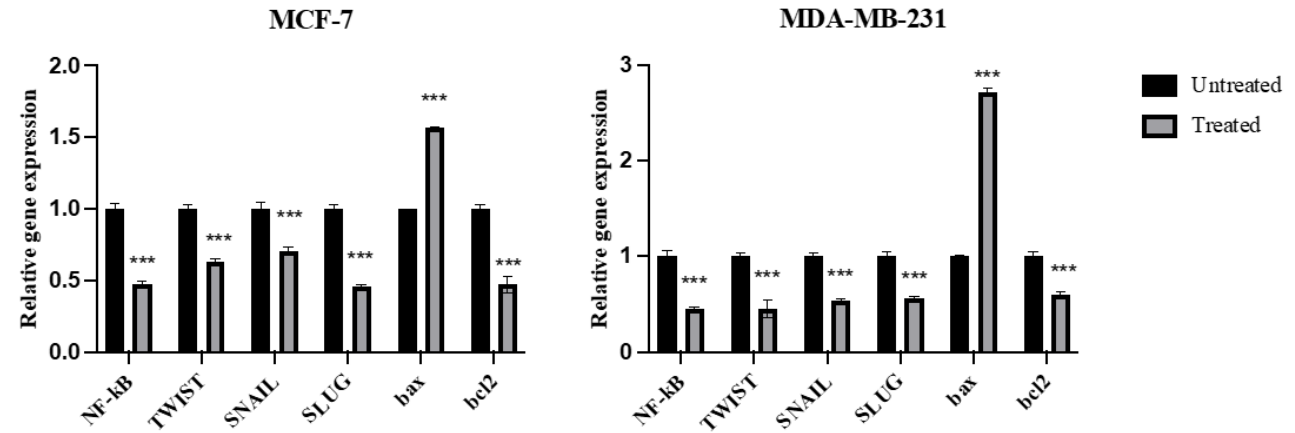
Figure 7. Effect of azilsartan on the expression of NF-kB, TWIST, SNAIL, SLUG, bax and bcl2 genes in MCF-7 and MDA-MB-231 breast cancer cell lines. Relative gene expression in both cancer cells treated with the IC50 concentration of azilsartan compared to untreated cells. Expression was normalized to the corresponding GAPDH gene expression. Bars represent mean ± SD, n = 3. Significant difference was analyzed by two-way ANOVA, where *** p < 0.001, compared to untreated cells.